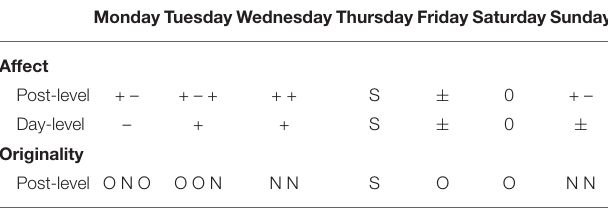
TABLE 1 | Affect and originality representation for a sample week. TABLE 2 | Demographics of the